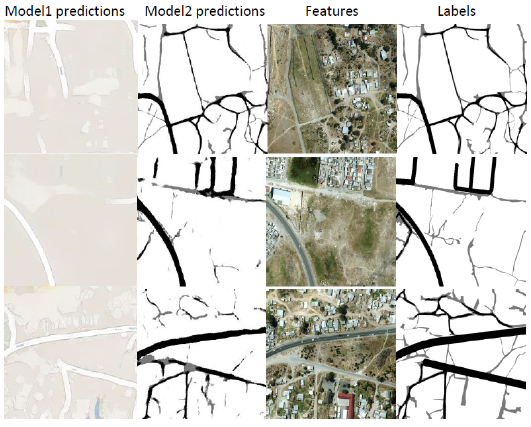
Figure 8. Results obtained from using the pre-trained maps2sat model (model 1) vs our trained model (model 2).